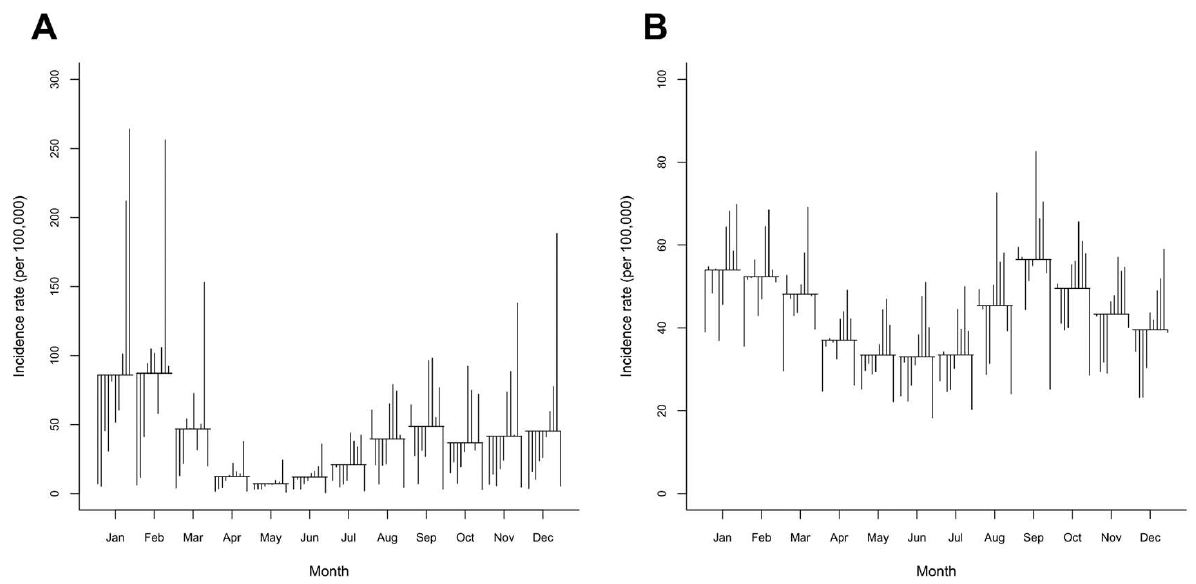
Figure 3. Seasonal cycle subseries (SCS) plots of the monthly incidence rates of ( A ) influenza and ( B ) pneumonia in Chiang Mai from 2011 to 2020. The SCS has a horizontal line for the average incidence rate of each month over the entire period, while each vertical line depicts the unique pattern for the same months in each